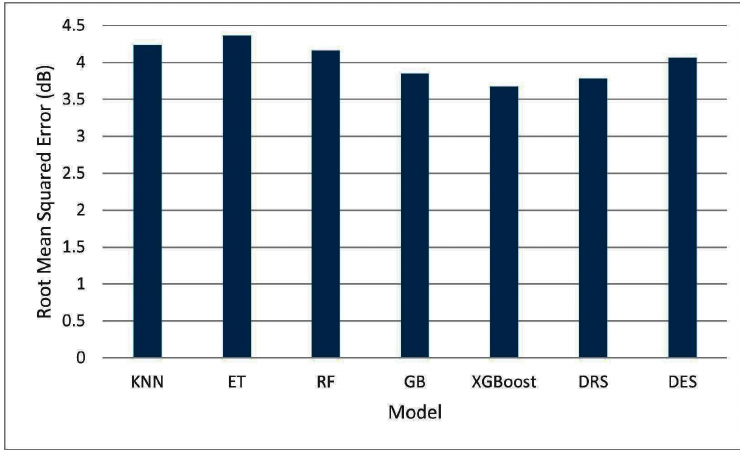
Figure 11. Root Mean Squared Error of models based on dataset 2.